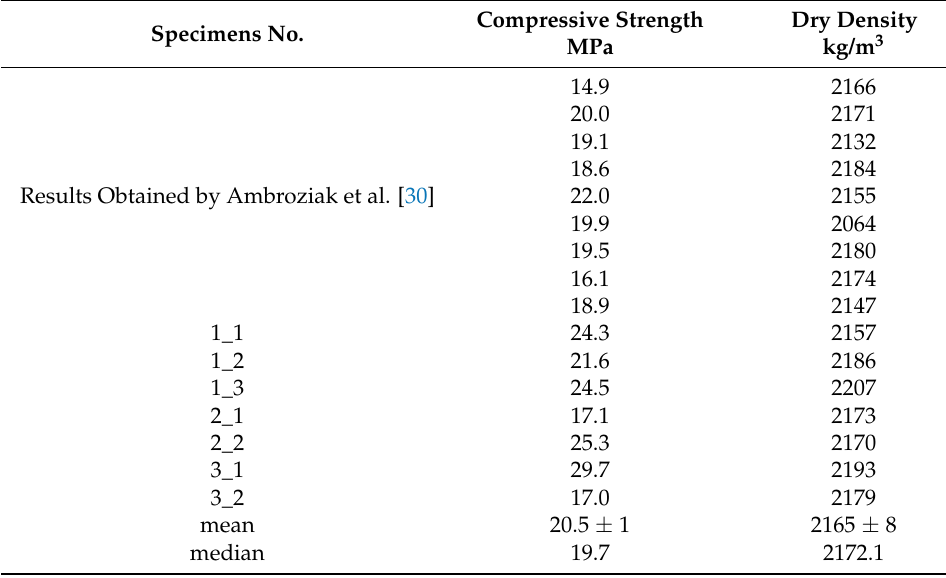
Table 1. Concrete compressive strength and dry density. Specimens No.